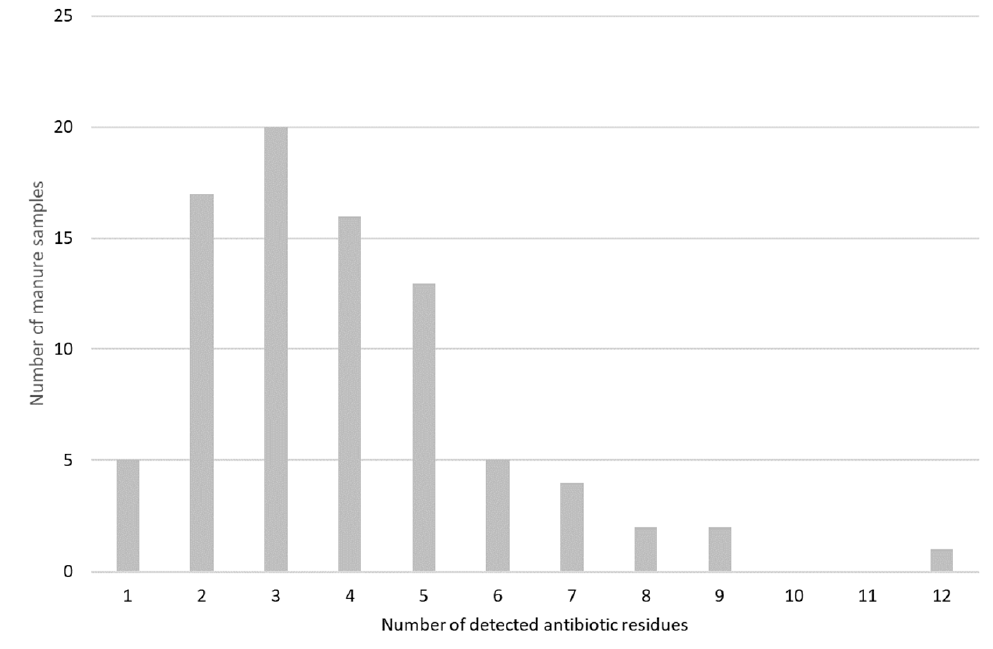
Figure 1. The number of pig manure samples relative to the number of detected antibiotic residues ( n = 85).